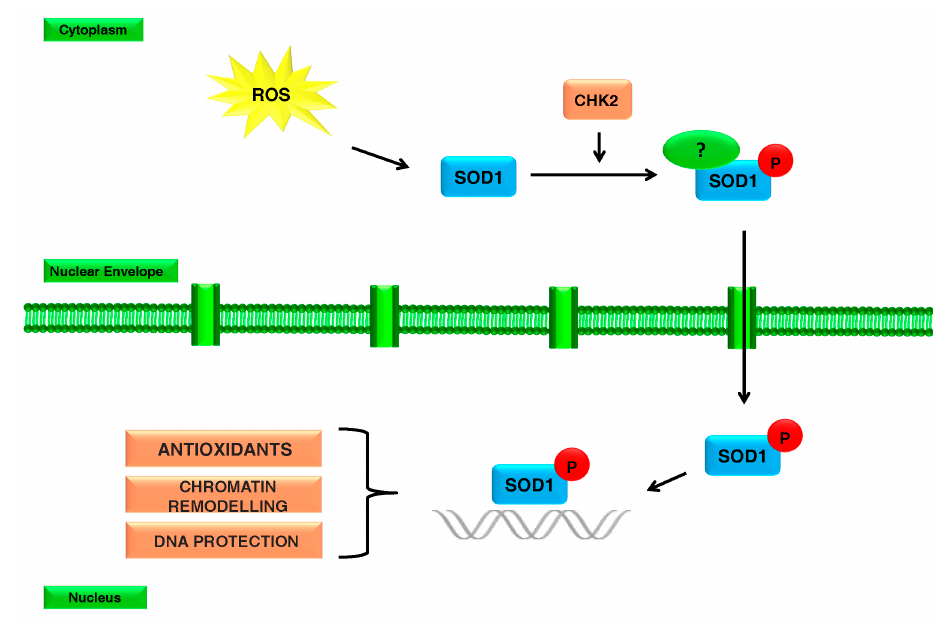
Figure 2. Schematic representation of SOD1 re-localization involving Chk2-mediated SOD1